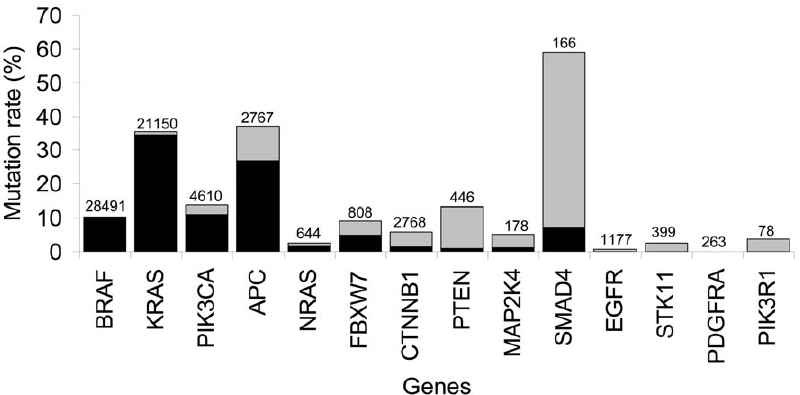
Figure 1. Total coverage of the 14 genes investigated, based on the COSMIC database. On the x-axis the analyzed gene. On the y-axis the mutation percentage is shown, based on large intestine carcinomas in the COSMIC database. In grey, the mutation percentages according to the COSMIC database, in black the mutation percentage covered by this study, on top of the bars the total number of analyzed samples found in the COSMIC database.